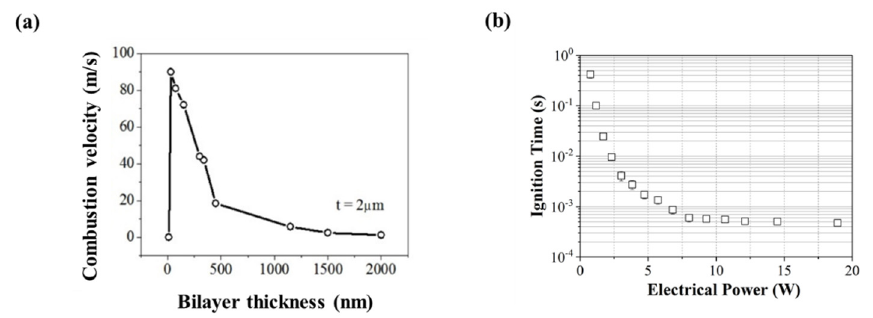
Figure 2. ( a ) Sustained combustion velocity in air of free-standing multilayers as a function of bilayer thickness (total thickness t = 2 µm); ( b ) ignition time as a function of the electrical power sent through the micro-heater for 5 bilayers of Al/CuO.